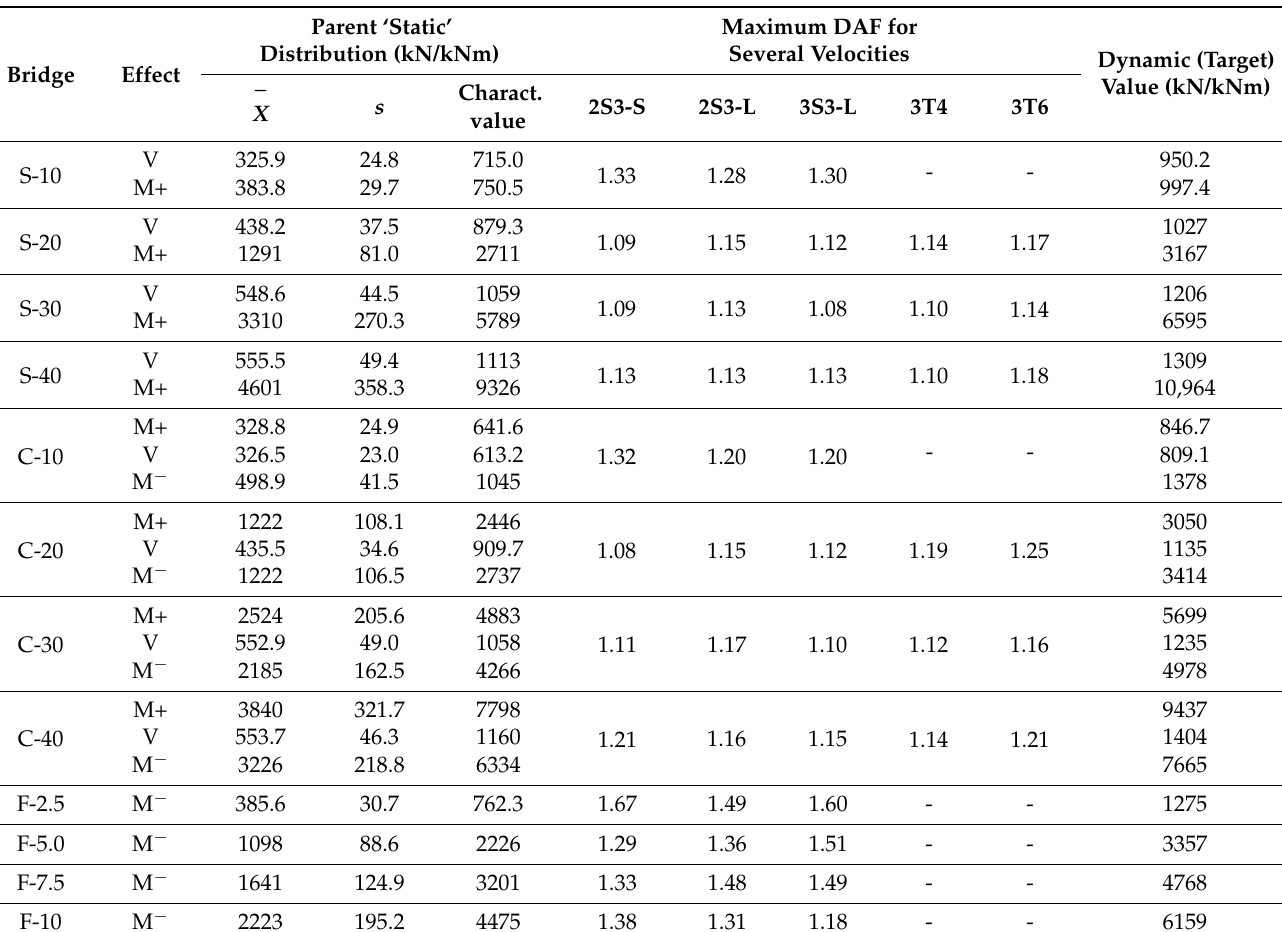
Table 7. GVWs and wheelbases of standardized 3C equivalent vehicles for each truck